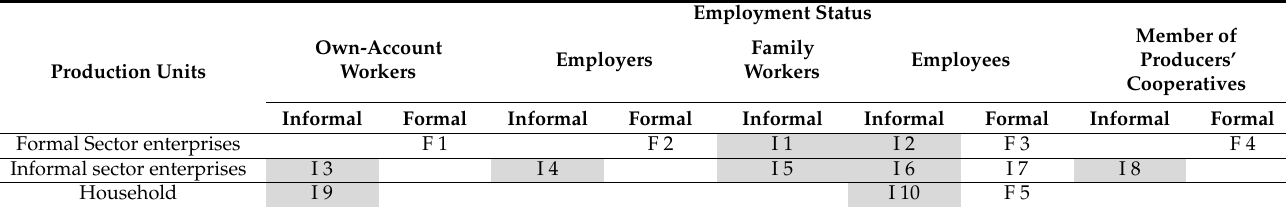
Table 1. Building block approach to describe formal and informal employment. Adapted from International Labour Organization, 2013 [12]. Copyright © International Labour Organization 2013.